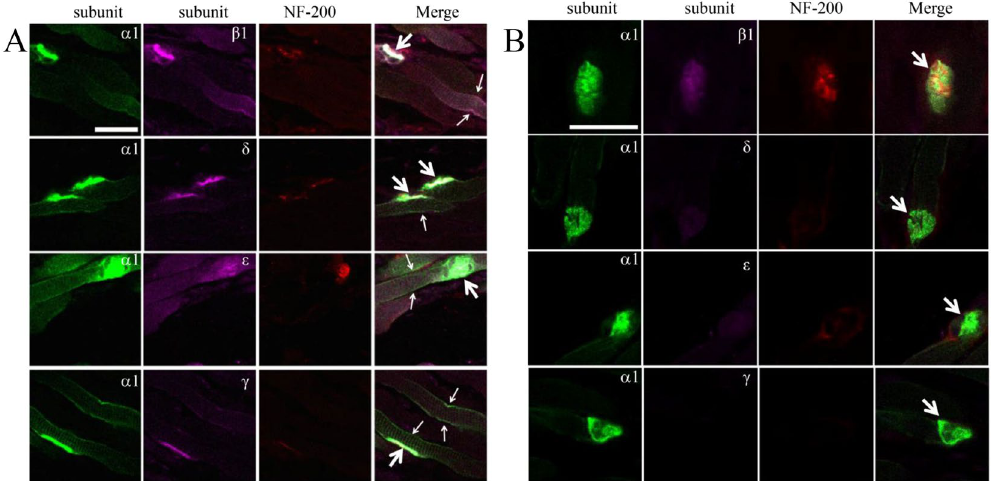
Figure 6. Confocal micrographs showing localization of the α 1, β 1, δ , ε , and γ subunits at the NMJs and muscle membrane of ( A ) DIV (grade IV) facial nerve injury of the orbicularis oris on day 7 and ( B ) DIV facial nerve injury of the orbicularis oris on day 30. Immunofluorescence staining with α -bungarotoxin (green, mark α 1 subunit), β 1, or δ or ε or γ subunits (pink), and neurofilament 200 (red, mark nerve). Large arrows mark the NMJ, and small arrows mark the muscle membrane. Scale bars = 30 μ